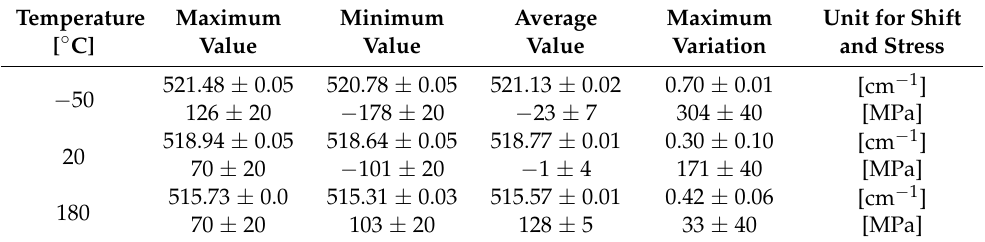
Table 5. Raman shift [cm − 1 ] and stress values [MPa] obtained for the A_AuSn_p sample. Temperature